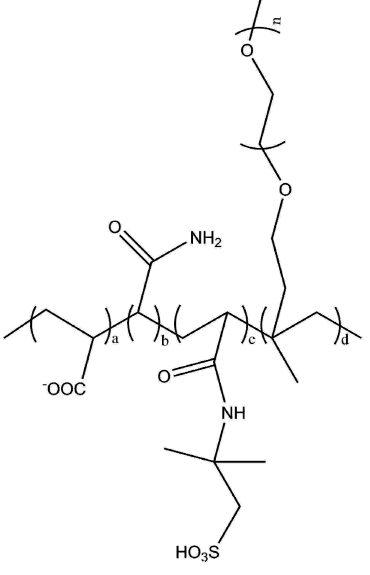
Figure 1. Molecular architecture of PCs.